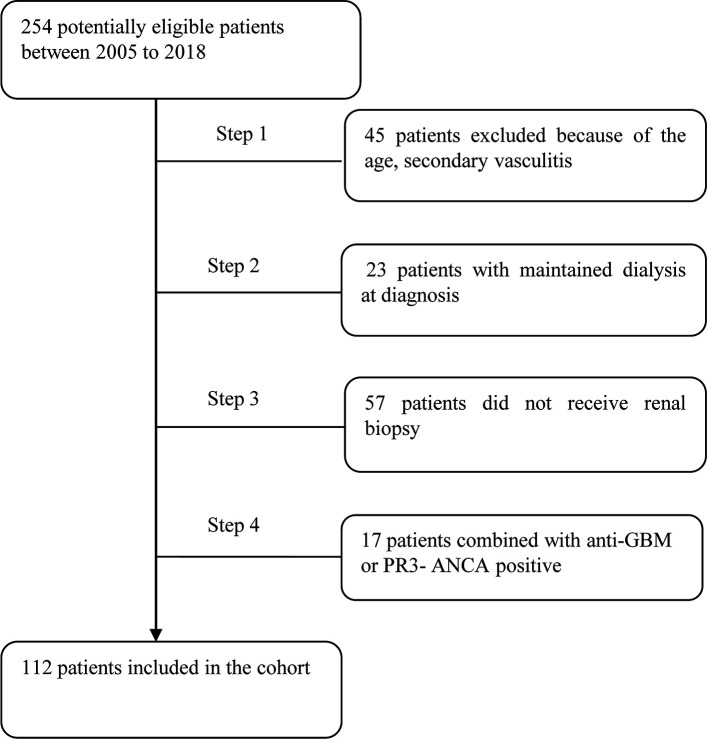
Flow diagram of patients. GBM, glomerular basement membrane.